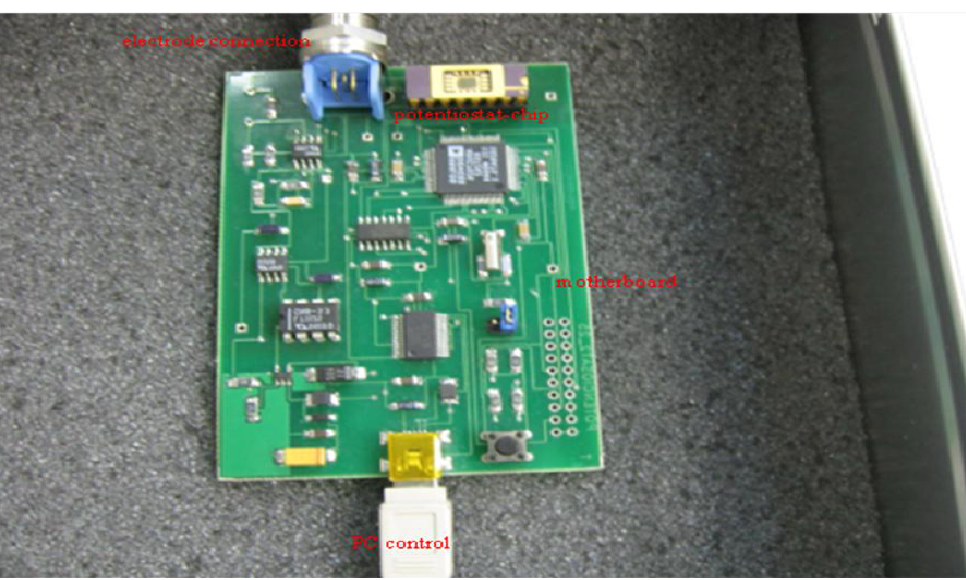
Figure 5. Photo of homemade potentiostat with chip and controlling